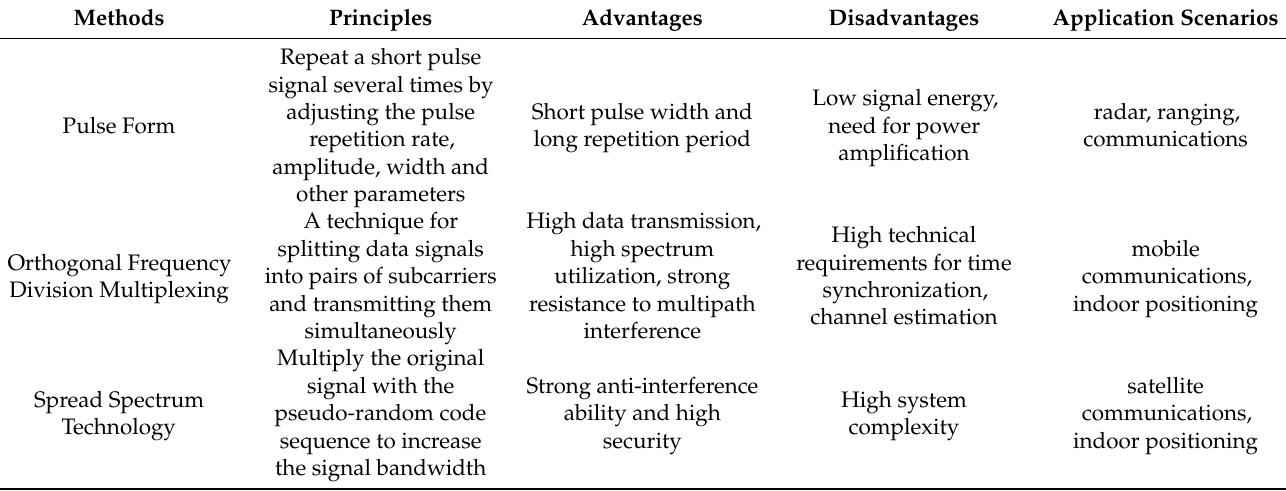
Table 1. Principles and characteristics of ultra-wideband signal generation